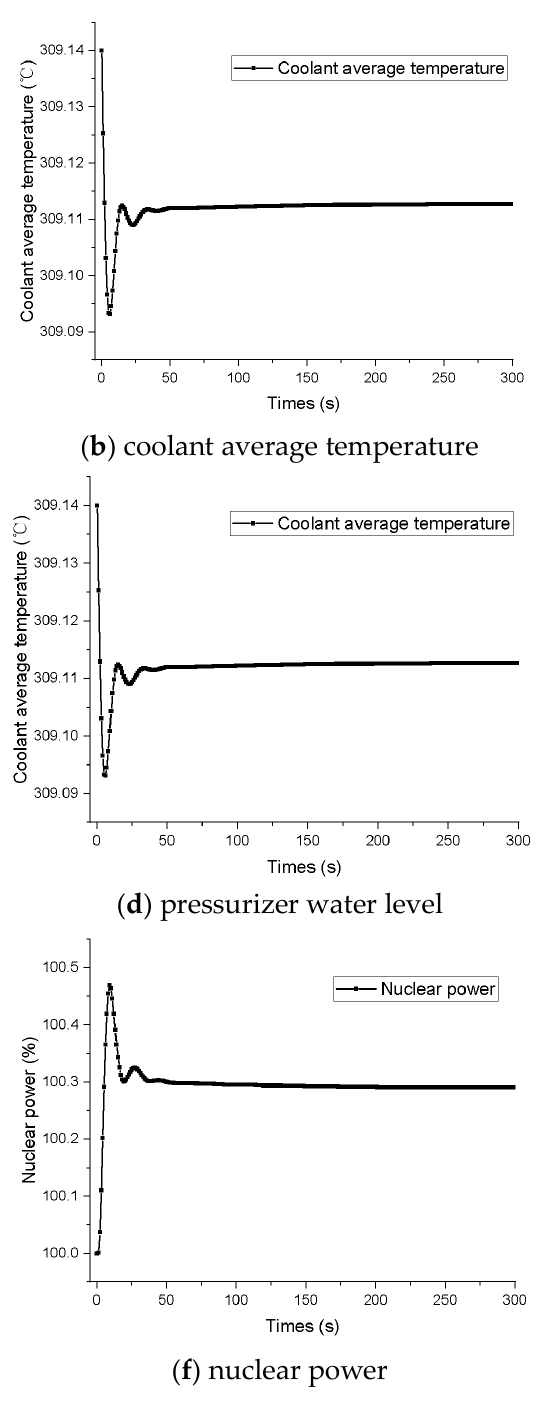
Figure 6. Operating trend of normal